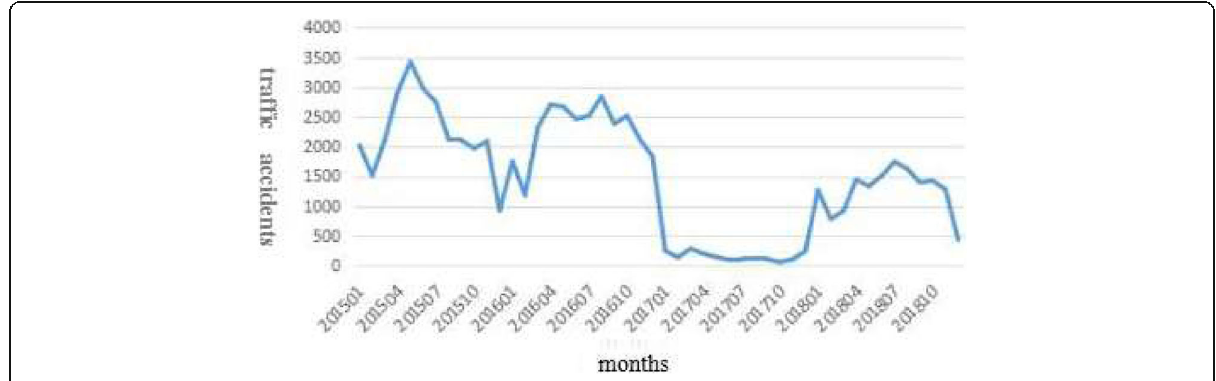
Fig. 1 Overall incidence of traffic accidents in Beijing in 2015 – 2018